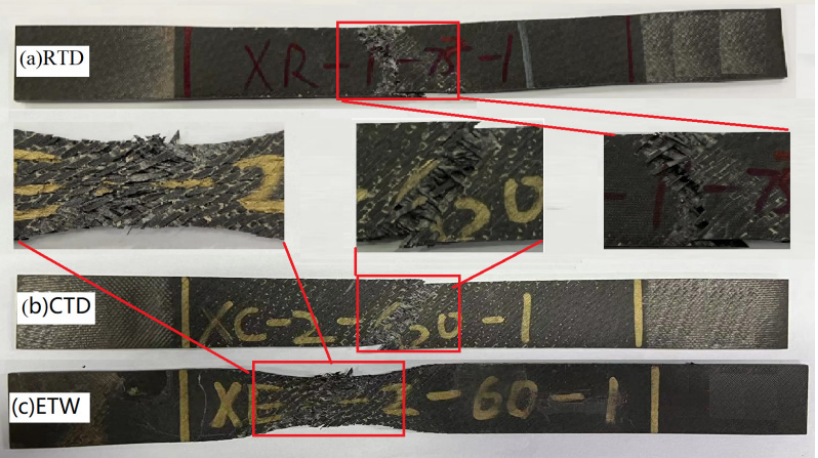
Figure 6. Fatigue failure morphology in three environments. ( a ) RTD; ( b ) CTD; ( c ) ETW.